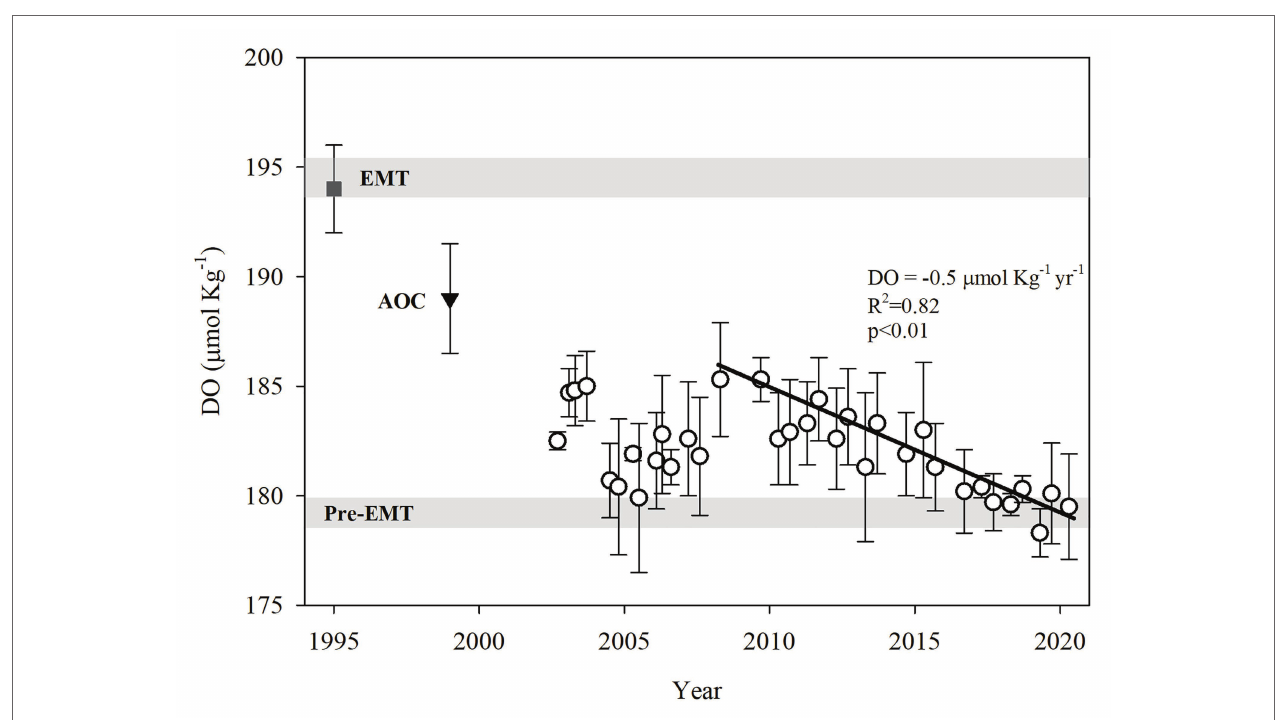
FIGURE 2 | Temporal variation of the mean oxygen concentrations measured in the deep layer (1200–1750 m) at station H06, during the period 2002–2020 (black circles). The error bars are the SDs of all the measurements made within this depth range in each cruise. The thick gray line indicates the pre-eastern mediterranean transient (EMT) oxygen concentration. The EMT and accelerated oxygen consumption (AOC) oxygen levels in the EMS, indicated by ■ and ▲ , respectively, are from Klein et al. (2003). The black trend line denotes the long-term decreasing trend in oxygen levels since